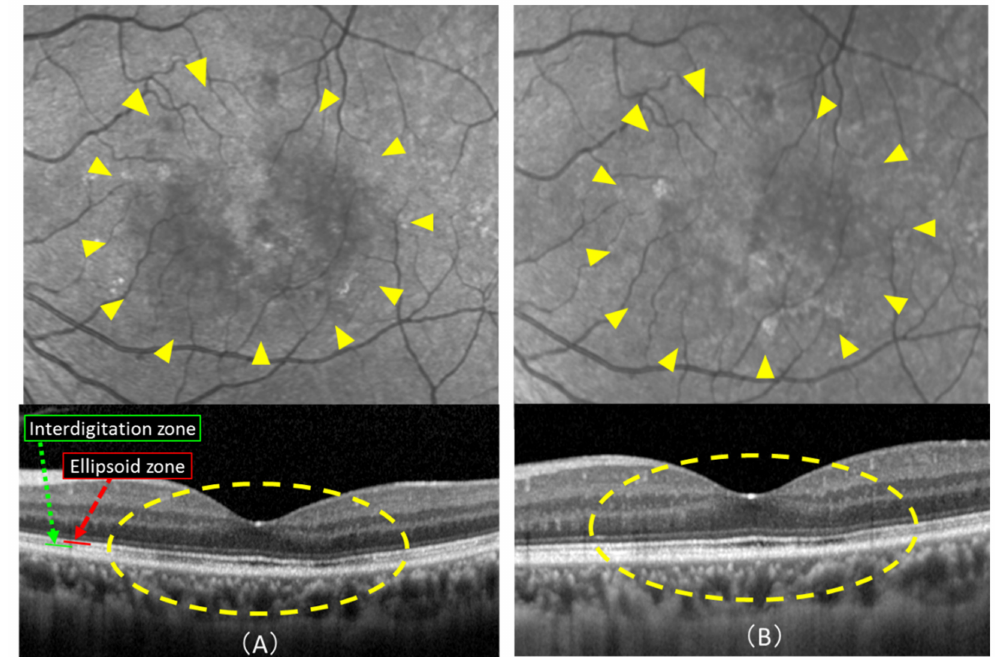
Figure 4. Infrared reflectance (IR) images and optical coherence tomography (OCT) scans 1 month and 3 months after half-dose photodynamic therapy (hPDT): ( A ) 1 month after hPDT: upper image shows IR image and lower is an OCT scan. There is no detachment in the macular area at 1 month after treatment, but IR image shows a slightly hypofluorescent area (yellow arrowheads). The mean luminance of the IR image was 121.4. ( B ) 3 months after hPDT: Compared with 1 month after treatment ( A ), the area of hypofluorescence has decreased on IR (yellow arrowheads) image, and the mean luminance has also increased to 131.2. The ellipsoid and interdigitation zones (yellow dotted line) also show